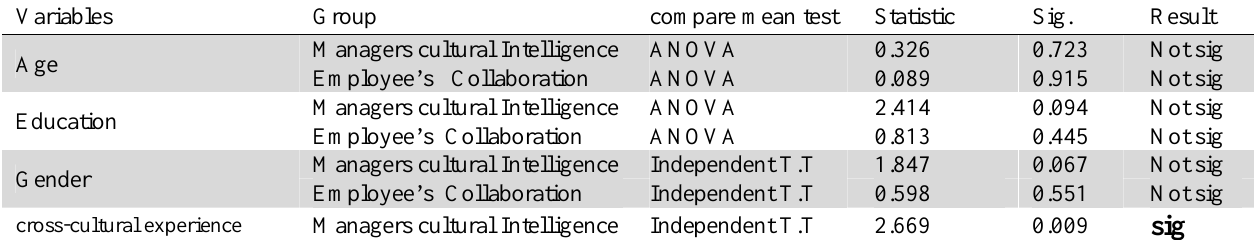
Results of the comparison of the average at demographic variable levels Variables